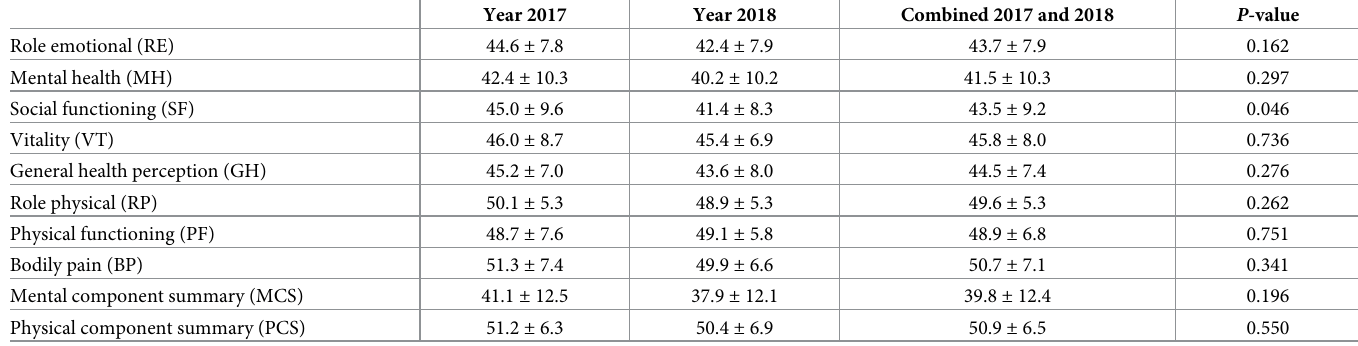
Table 3. Comparison of quality of life dimensions scores (mean ± standard deviation) with Short Form-8 (SF-8) scores among University of California Davis house officers in 2017 (n = 60) and 2018 (n =